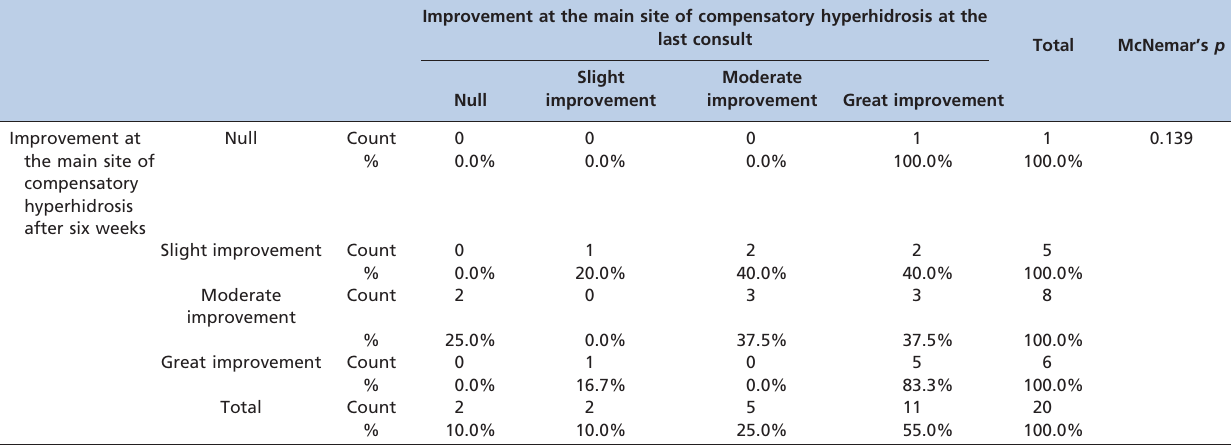
Table 3 - Improvement at the main site of hyperhidrosis after six weeks and at the last consult (median: 385 days). Improvement at the main site of compensatory hyperhidrosis at the last consult